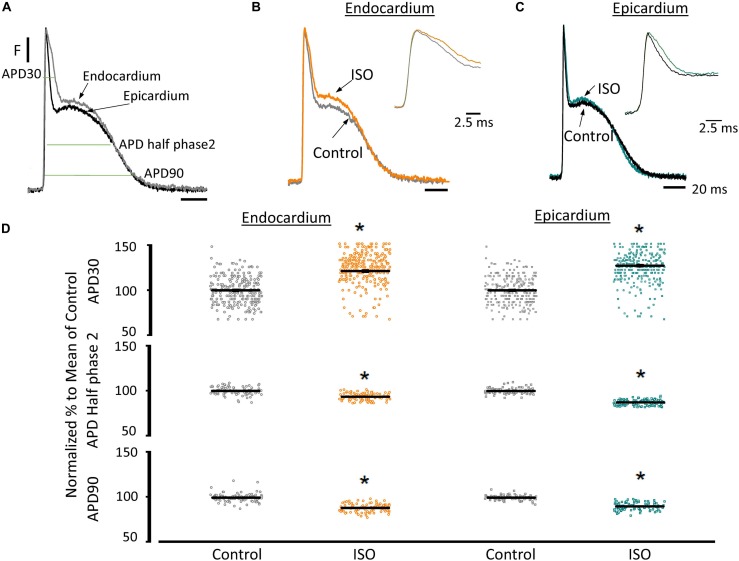
β-Adrenergic stimulation modifies AP morphology in endocardium and epicardium. (A) Normalized APs from the endocardium (gray) and epicardium (black) recorded optically using Di-8-ANEPPS and the pulsed local field fluorescence microscopy technique. The evaluated AP parameters are marked. (B) Normalized APs from the endocardium before (gray) and after perfusion with 500 nM isoproterenol (ISO; orange). Inset: Expanded view of AP phase 0 and 1 to visualize the isoproterenol effects. (C) Normalized APs recorded from the epicardium before (black) and after perfusion with 500 nM isoproterenol (cyan). Inset: Expanded view of AP phase 0 and 1 to visualize the isoproterenol effect. (D) Summary of the normalized APD30, APD half phase 2 and APD90 changes from the endocardium (circles) and epicardium (squares), before and after isoproterenol. Means ± SEM are represented as the solid horizontal lines. *p < 0.01, N = 4 hearts.